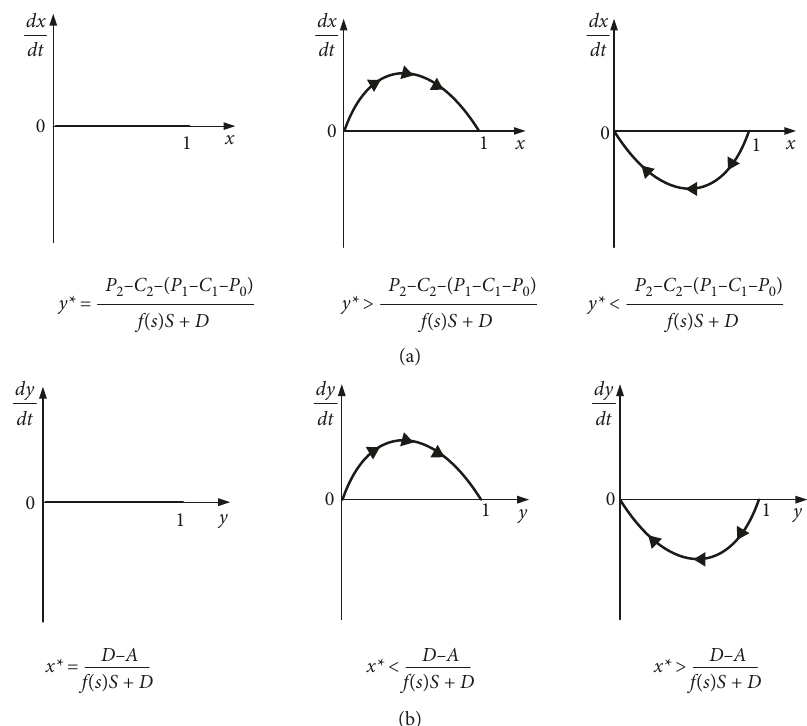
Figure 4: Replicator dynamics phase diagram of (a) the traveler and (b) the government.